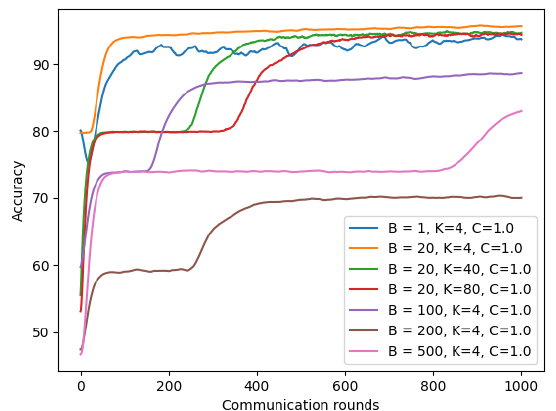
Figure 16. Non-IID with different batch-size and client based on symptom data. Table 10. Non-IID with refined Non-IID based on symptom data.